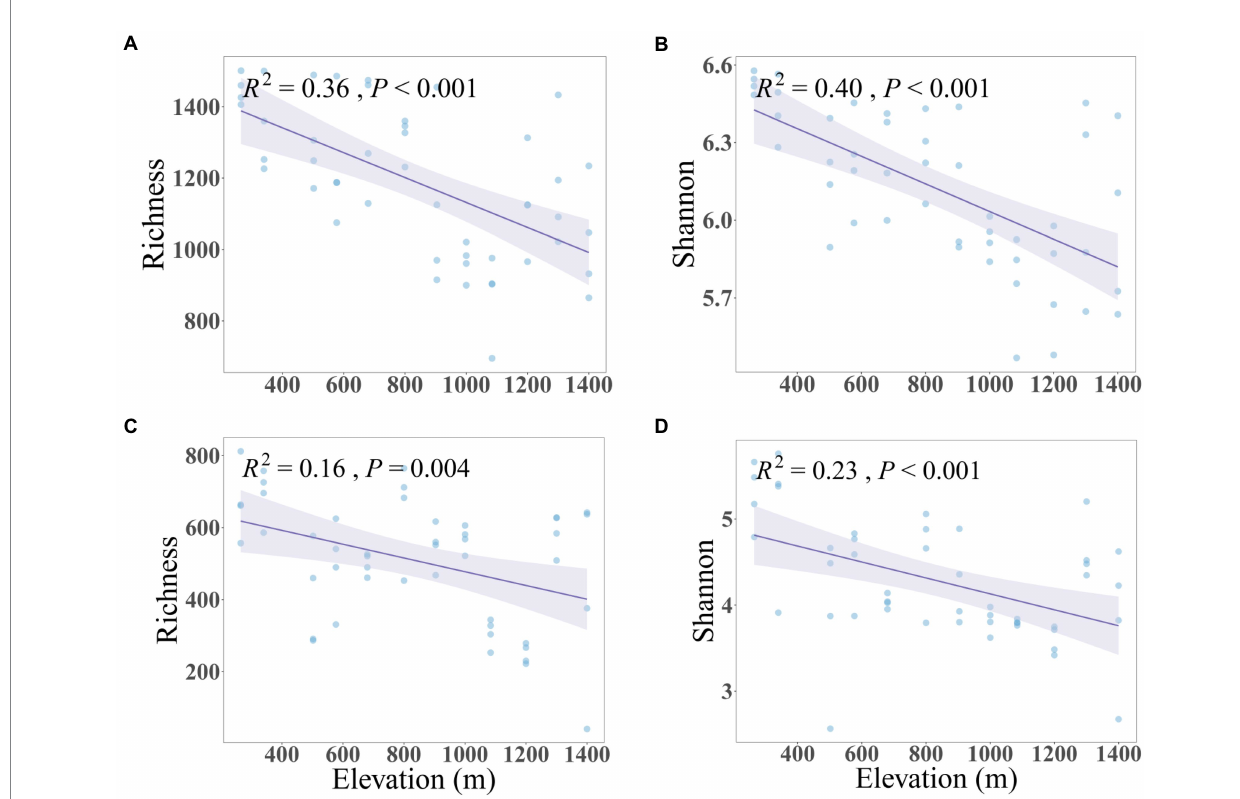
FIGURE 1 Linear relationships between soil bacterial (A,B) and fungal (C,D) diversity and elevation. The solid lines and confidence intervals show predicted relationships and 95% confidence intervals from ordinary least squares linear